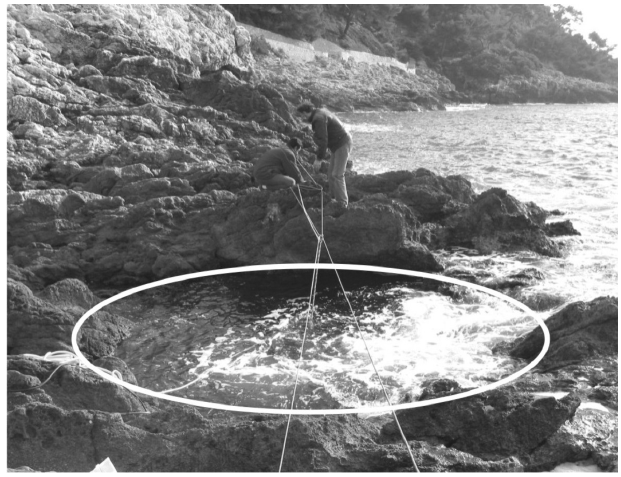
Figure 1. Small-scale site morphology; the white circle highlights the vertical submarine cave structure. Ropes were used for supporting probes and sampling